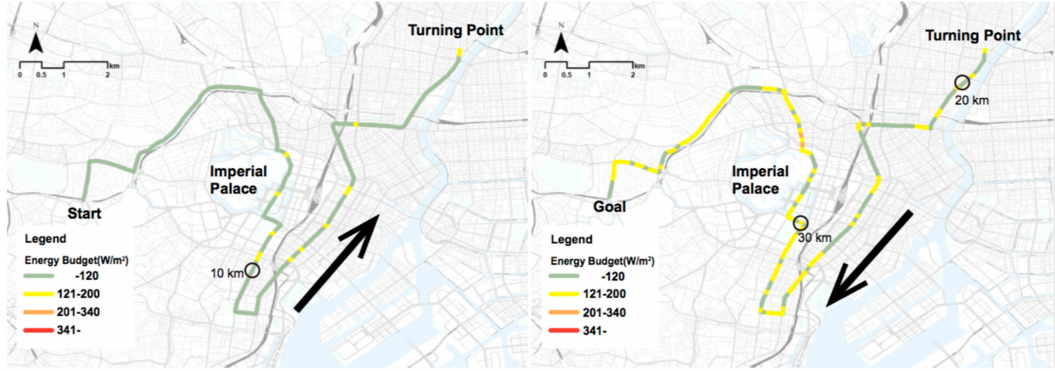
Figure 7. Energy budget for the best-case scenario mapped on the marathon route (left: outward; right: